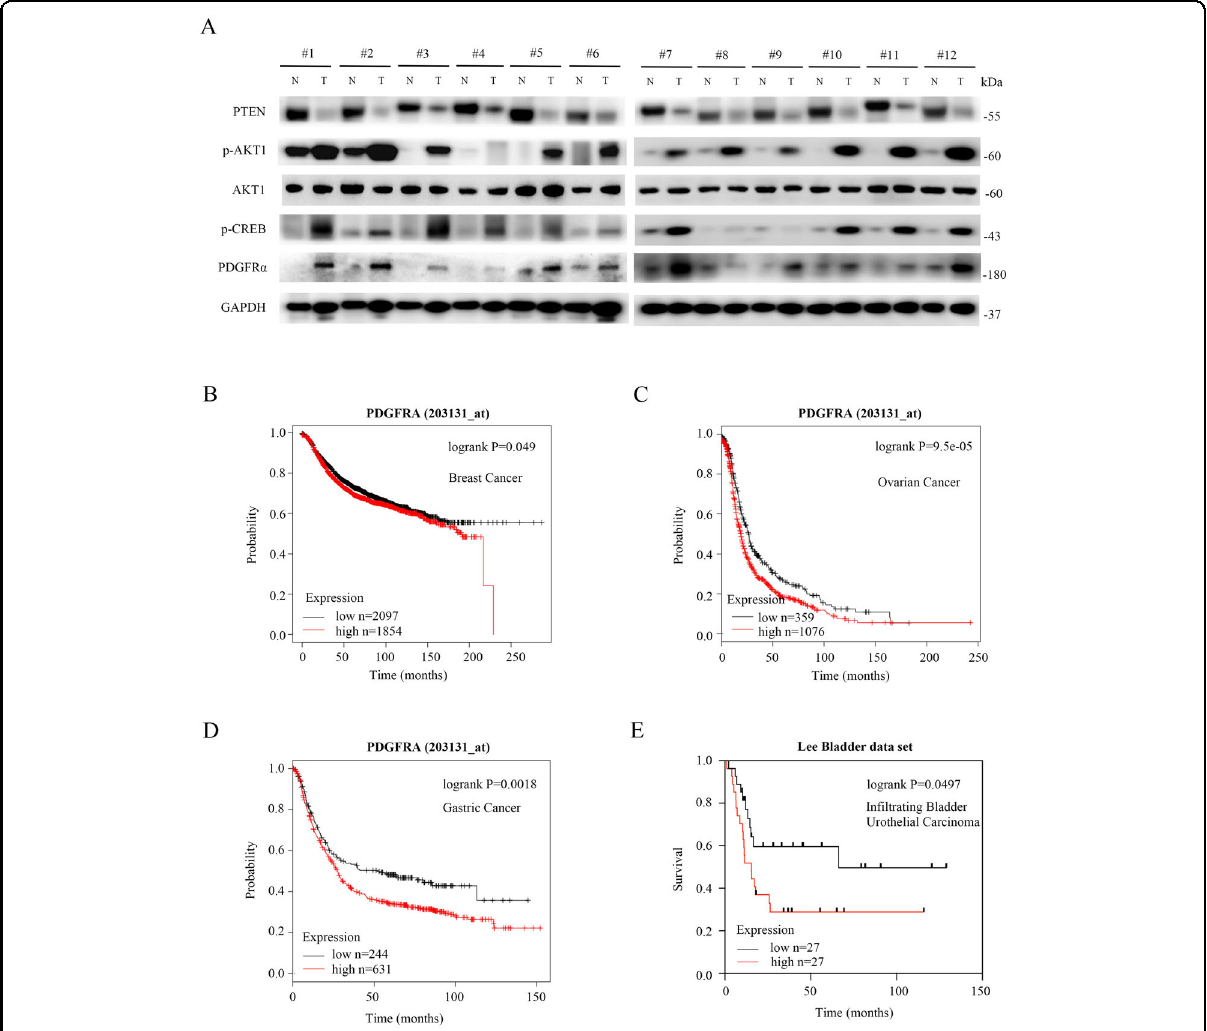
Fig. 7 PTEN is negatively correlated with p-AKT1, p-CREB, and PDGFR α in human breast tumors, and PDGFR α is associated with poor survival in multiple tumors. A 12 paired of human invasive breast cancer tissues (T) and adjacent normal tissues (N) were subjected to immunoblotting with the indicated antibodies. B – D Choose the best probe set of PDGFRa (203131_at) in the Kaplan-Meier Plotter database (www. kmplot.com) to analyze the relapse-free survival (RFS) of cancer patients. Patient samples were split into two groups (high vs. low expression) by choosing “ Auto select best cutoff ” . Draw Kaplan-Meier plot without restrict analysis to any subtypes or clinical cohorts. Survival curve based on overall survival follow-up time as a prognostic indicator in breast cancer ( B ), ovarian cancer ( C ), and gastric cancer ( D ). E Analysis of Lee bladder data sets available through Oncomine (www.oncomine.org) indicates a signi fi cant correlation between high PDGFR α expression and poor survival in in fi ltrating bladder urothelial carcinoma. n is the number of patients for each